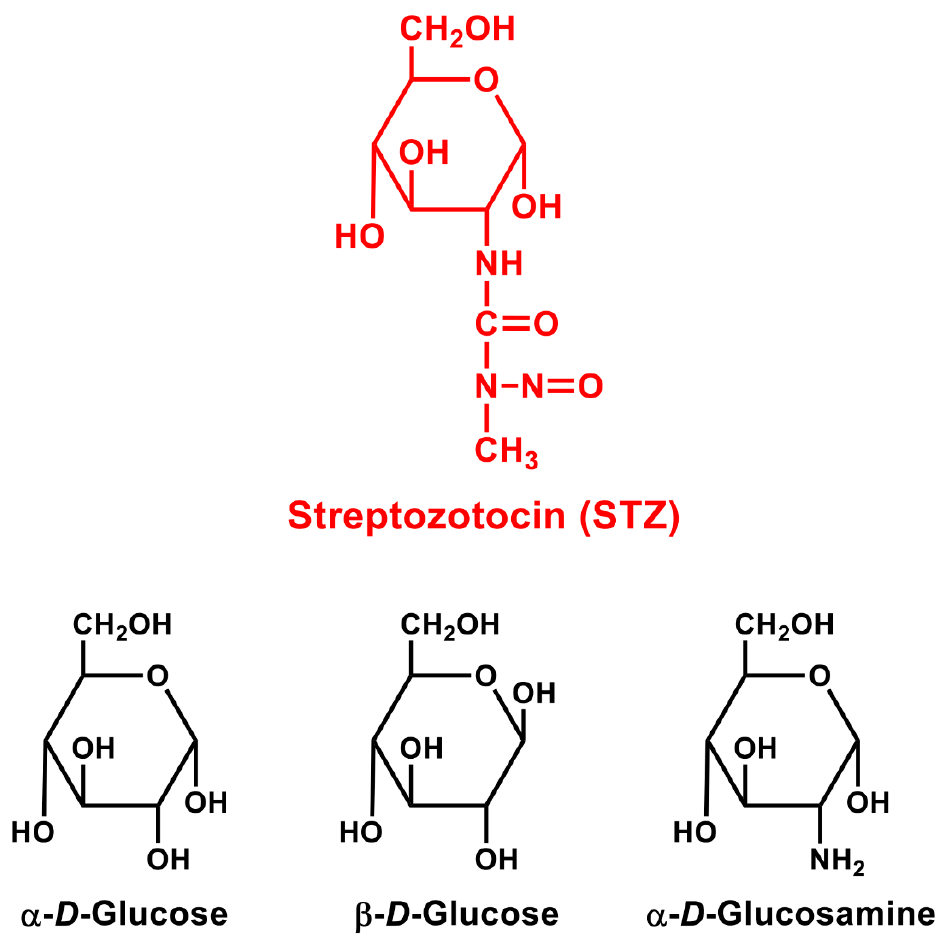
Figure 1. The chemical structure of STZ in comparison with α -glucose, β -glucose, and α - D -glucosamine. STZ contains an α -glucose chemical moiety, which is believed to be the structural basis for its ability to serve as a substrate for the glucose transporter GLUT2. It is of note that STZ also shares a close structural similarity to α - D -glucosamine.